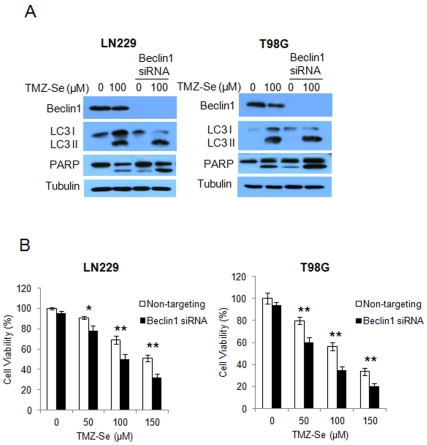
TMZ-Se induces calpain-mediated degradation of Beclin 1.(A) LN229 and T98G cells were transfected with Beclin1siRNA followed by TMZ-Se treatment, and the levels of LC3, Beclin 1 and PARP were examined by Western blot. Tubulin was used as a loading control. (B) LN229 and T98G cells were transfected with a Beclin 1-targeted siRNA, followed by treatment with TMZ-Se for 48h. Cell viability was measured by MTT assay. *p < 0.05; **p < 0.01.